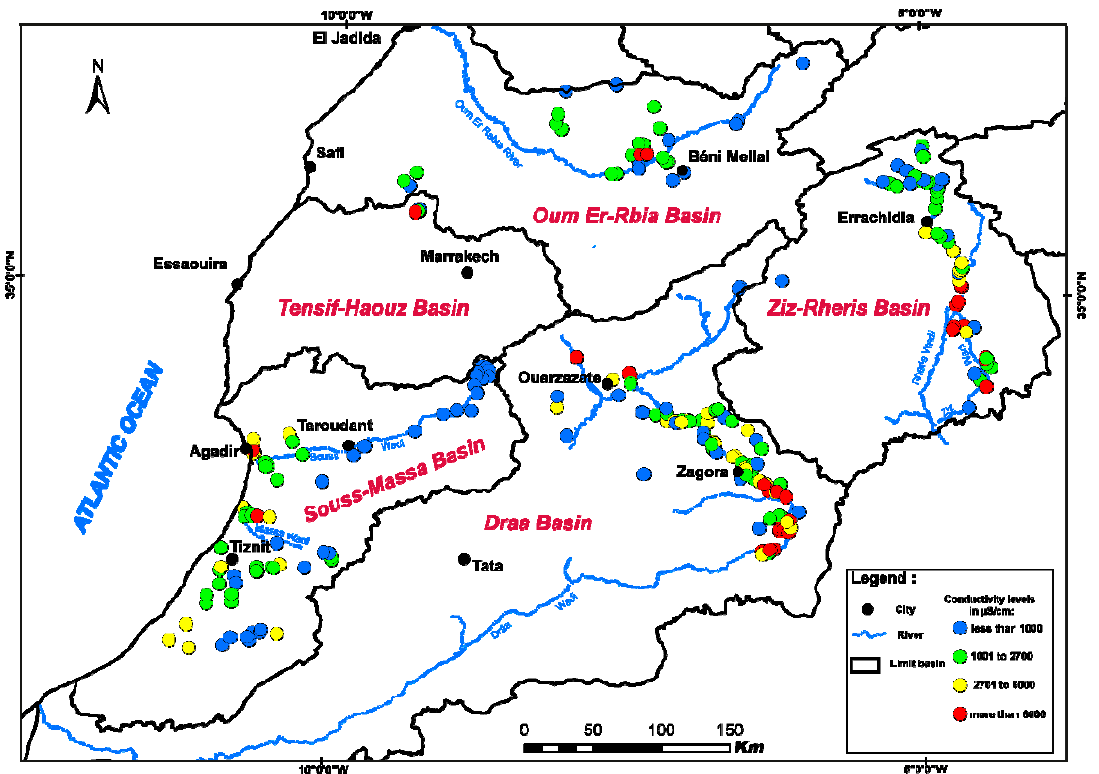
Figure 7. Groundwater salinity in four major basins in Morocco.